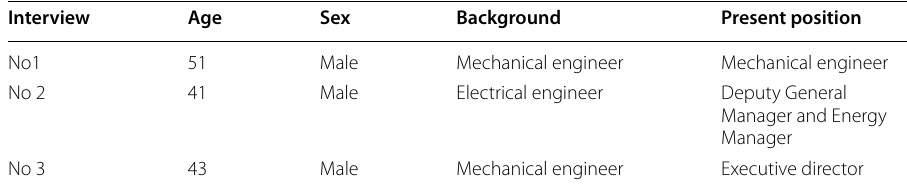
Table 4 Decision making members board